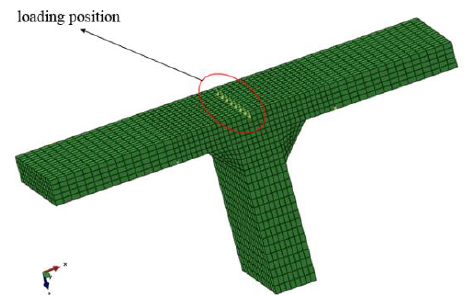
Figure 7: Loading position of 5A06+5083